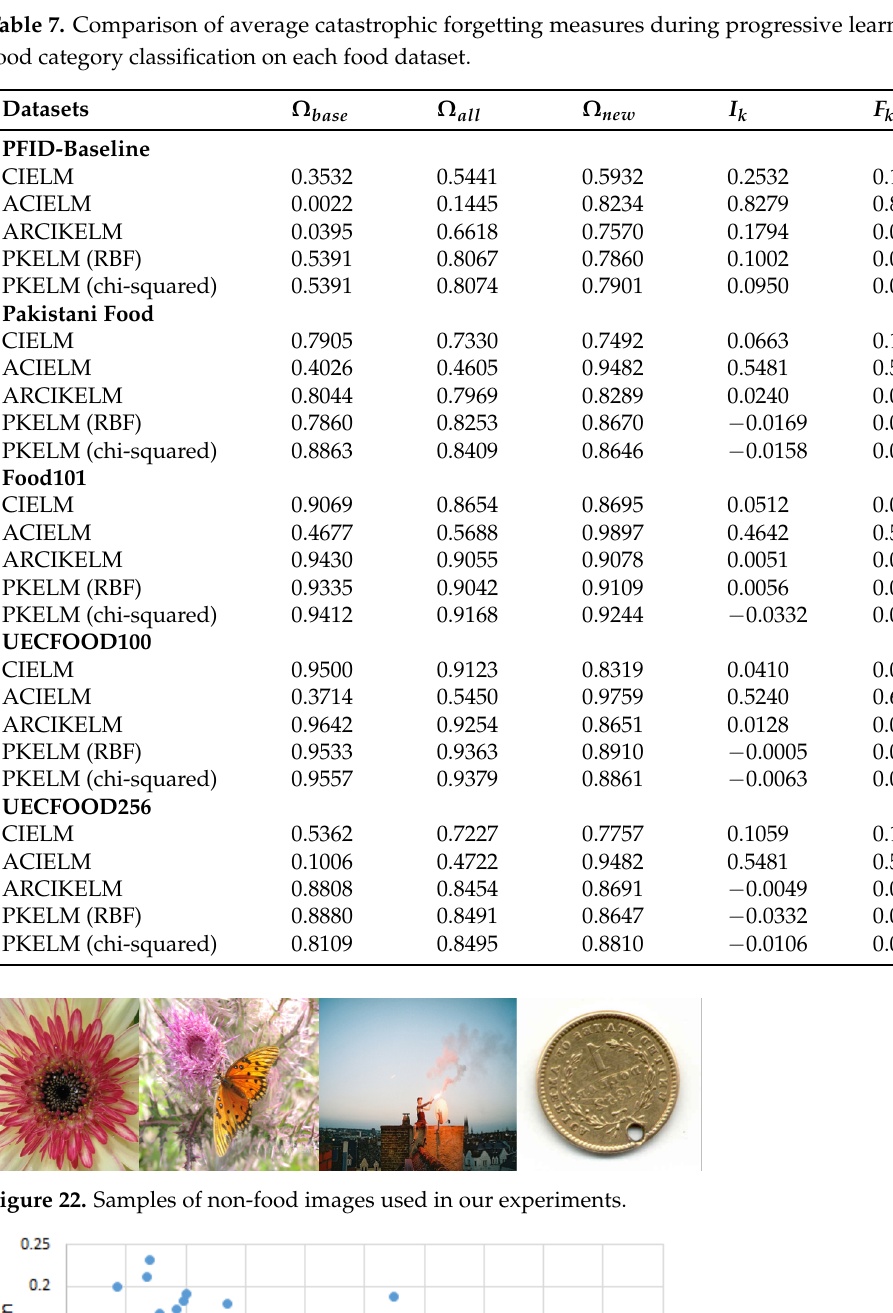
Table 7. Comparison of average catastrophic forgetting measures during progressive learning for food category classification on each food dataset.